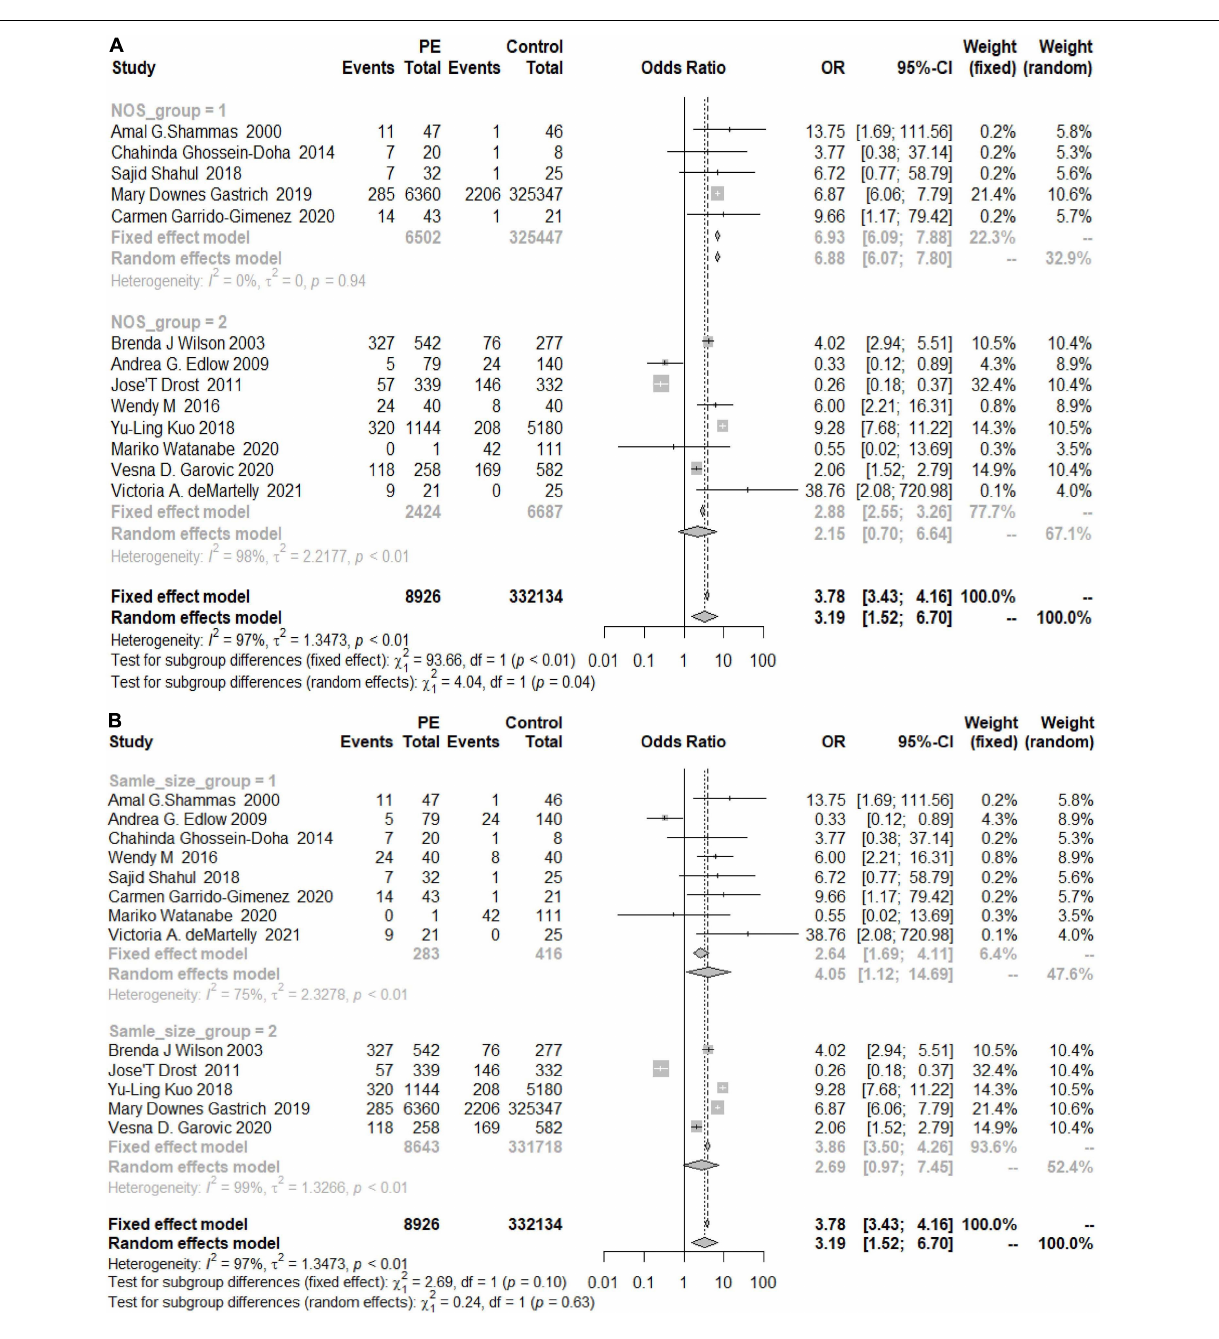
FIGURE 11 | (A) Subgroup analysis by NOS score of the risk of developing chronic hypertension in the PE group (Group 1 = NOS < 7, Group 2 = NOS ≥ 7). (B) Subgroup analysis by sample size of the risk of developing chronic hypertension in the PE group (Group 1 = sample size < 500, Group 2 = sample size ≥